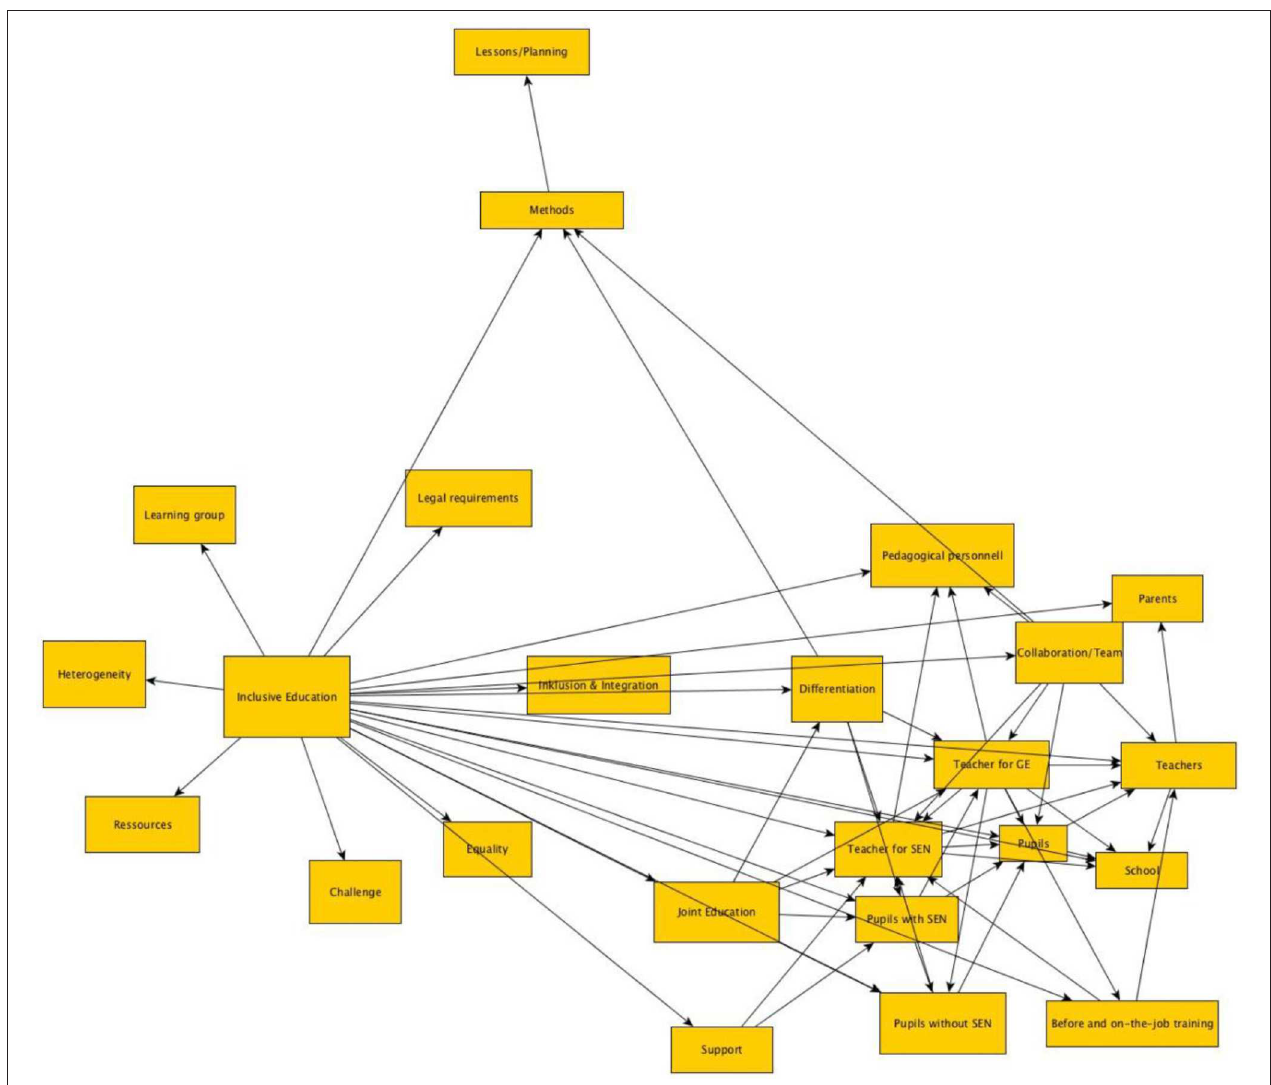
FIGURE 2 | Pathfinder network of all teacher trainees at t2 ( N =